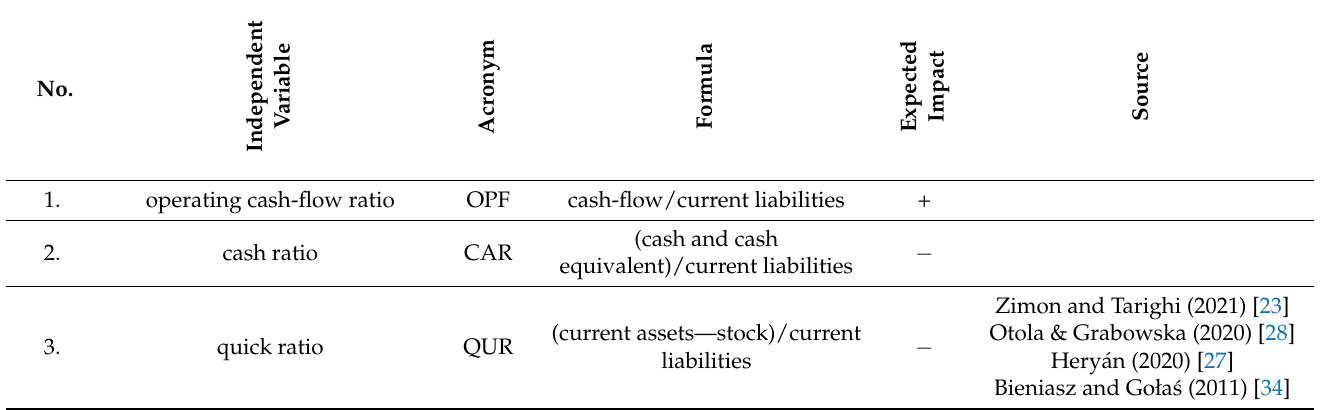
Table 3. Independent